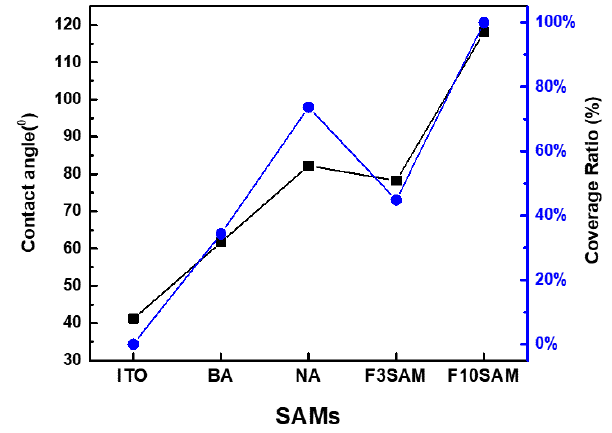
Figure 4. Contact angle measurement result and coverage quantitative ratio.